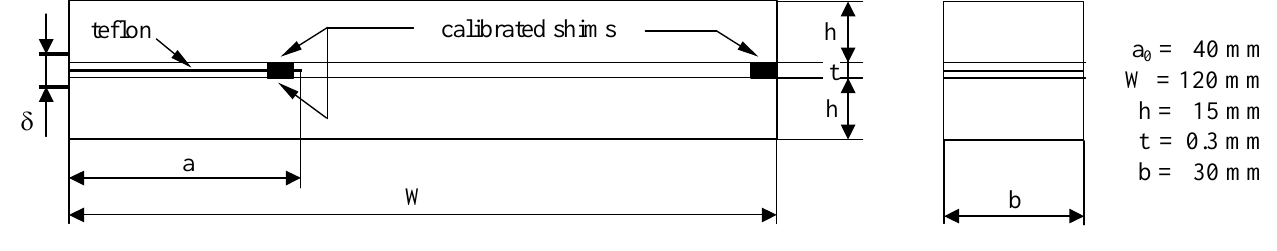
Figure 1: Outline of the DCB